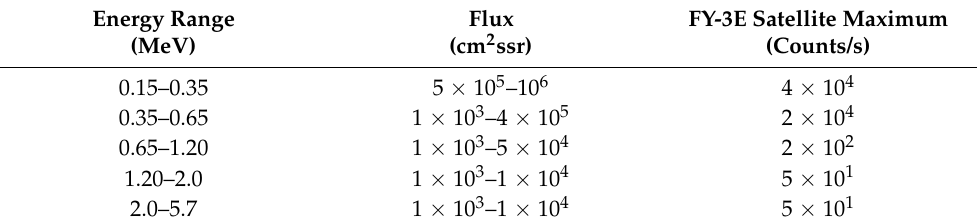
Table 5. Estimation of maximum count rate for high-energy electron